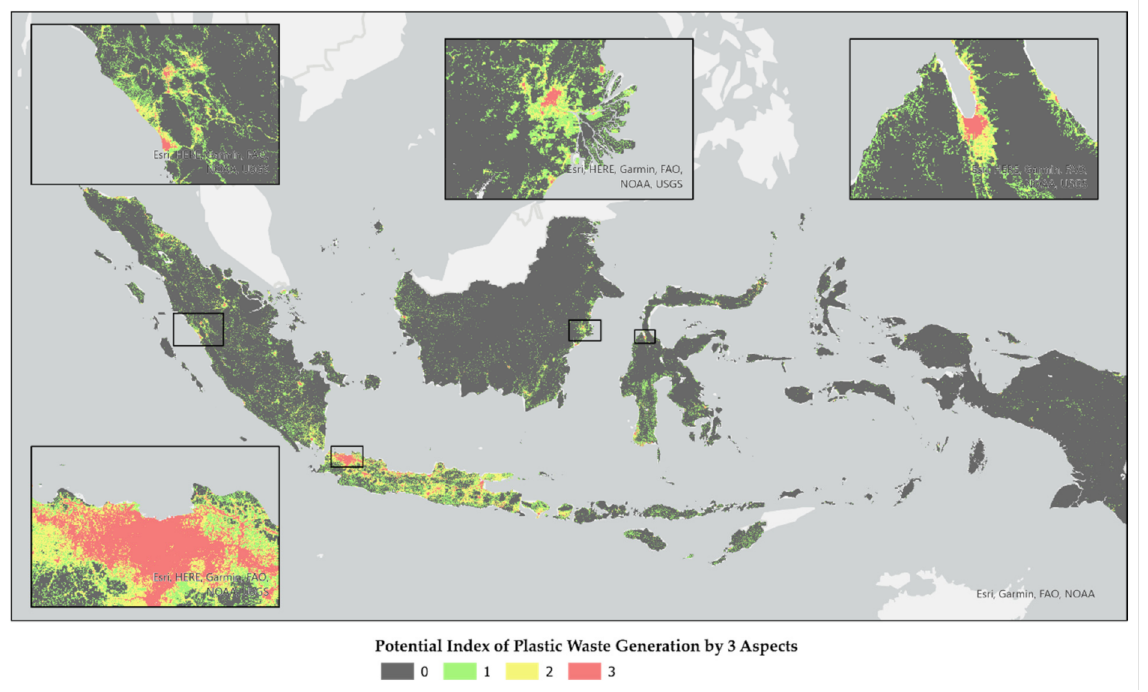
Figure 5. The potential index of plastic waste generation in Indonesia by three aspects. Quantitatively, Indonesia has an index value of 0 in 94.54% of the area. An index of 0 indicates that it is not an urban area and has a low population and economic level. The index values 1, 2, and 3 covered 4.72%, 0.65%, and 0.08%, respectively, out of a